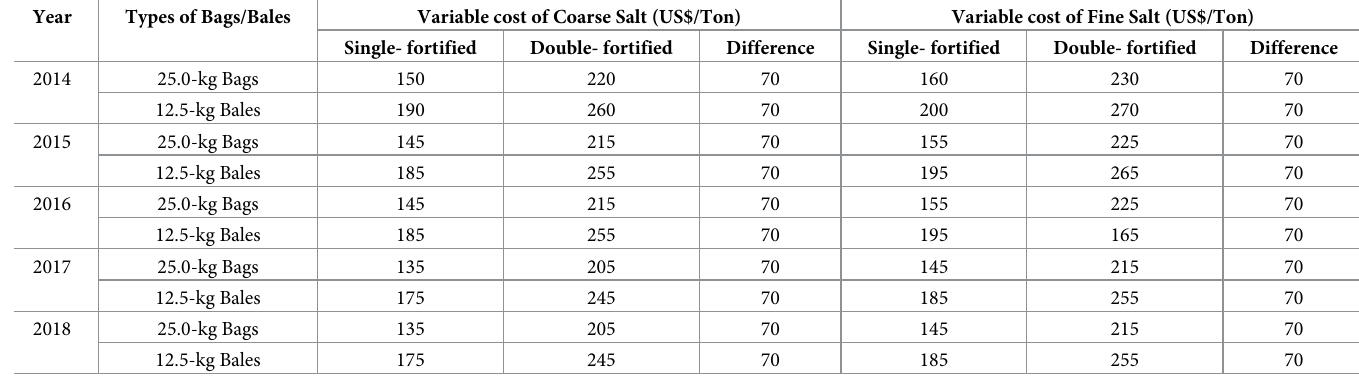
Table 3. Marginal cost of manufacturing DEC-medicated salt. This was evaluated by analysis of the difference in the variable costs of producing the single-fortified (which included only potassium iodate) versus the double-fortified (both potassium iodate and DEC included) salt types, given that the investment and fixed costs going into manufacturing all salt types were shared equally between each